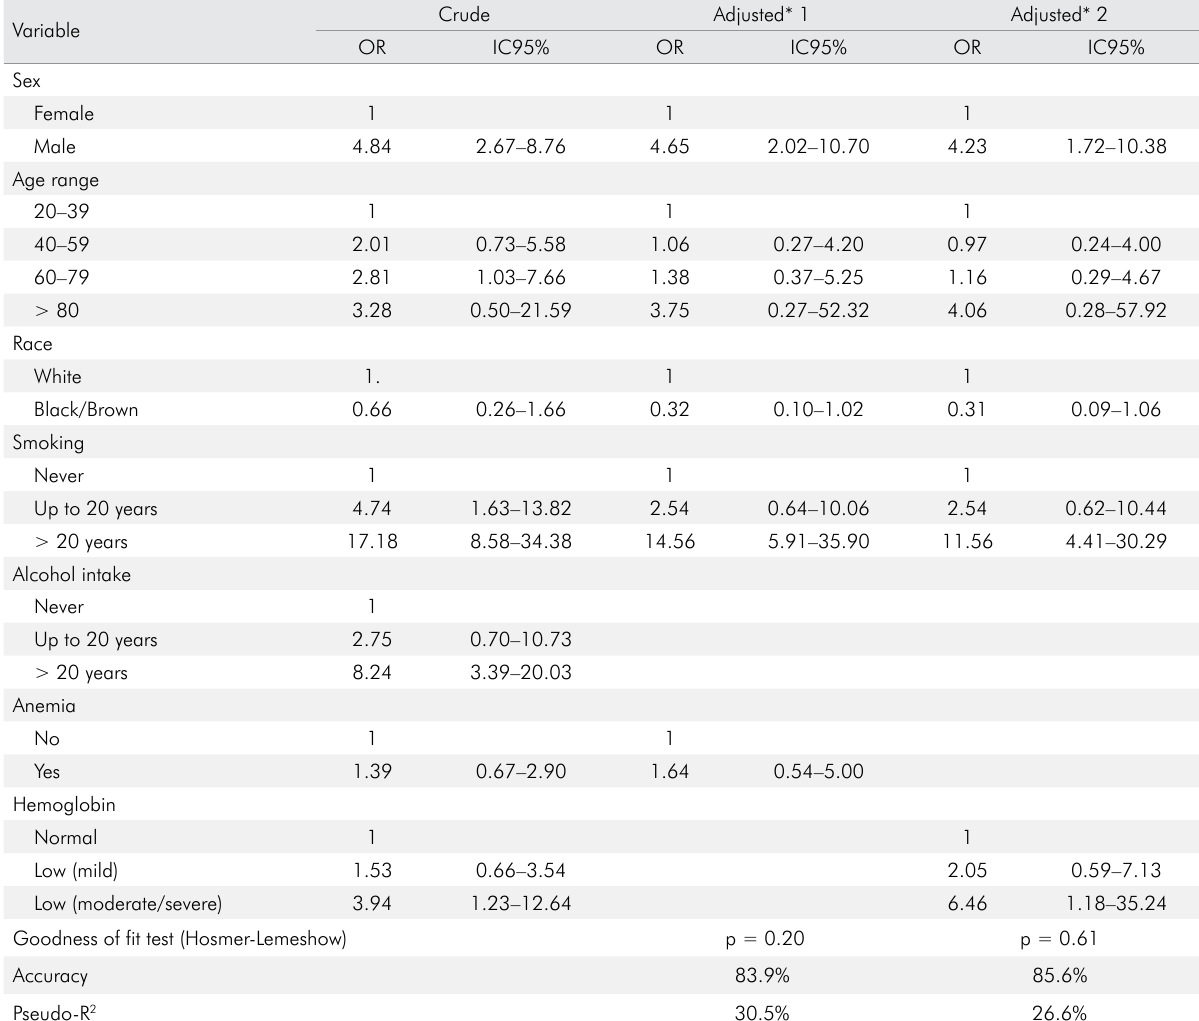
Table 2. Odds ratios (95%CI), crude and adjusted for associations between oral squamous cell carcinoma (OSCC) and demographic variables, behavioral variables, and